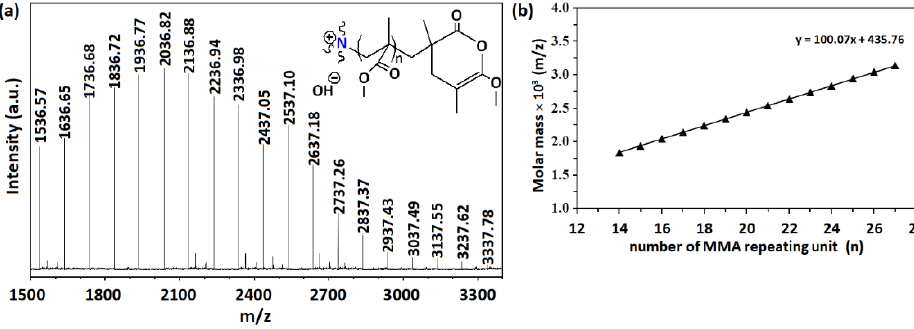
Figure 4. Low-MW PMMA obtained by using ZIF-L at 140 °C: ( a ) MALDI-TOF mass spectrum, ( b ) plot of m / z values against the number of MMA repeating units (n).